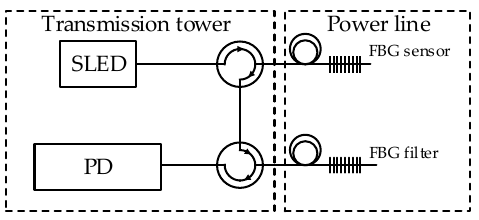
Figure 1. Interrogation system variant 1. SLED: superluminescent light-emitting diode; PD: photodetector.